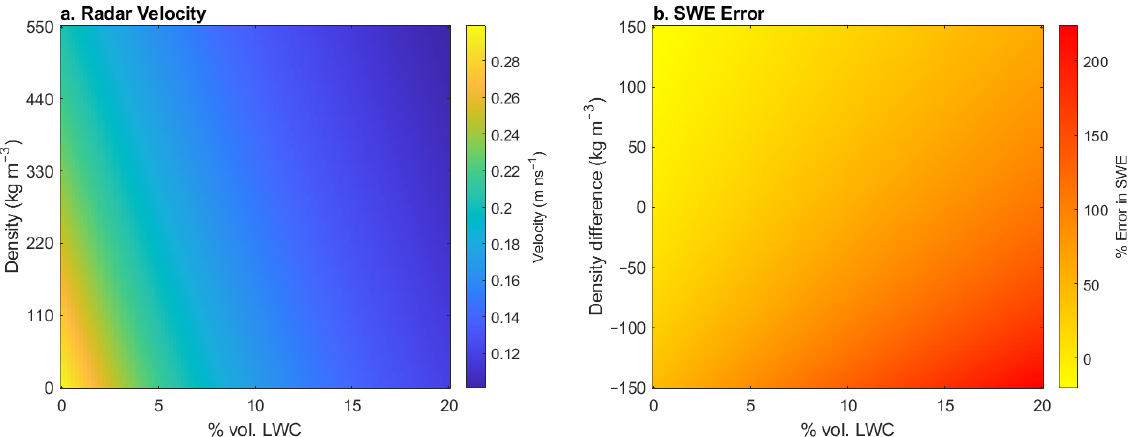
Figure 1. ( a ) Radar velocity in snow as a function of snow density and LWC. ( b ) SWE error calculated as the percent difference between an “assumed” SWE and a “true” SWE for a radar signal with a travel time of 5 ns in snow. “Assumed” SWE was calculated using 400 kg m −3 and 0% vol. LWC. “True” SWE was calculated using densities from 250 to 550 kg m −3 and LWC from 0 to 20% vol. These figures use Equation (3) to relate permittivity, density, and LWC.